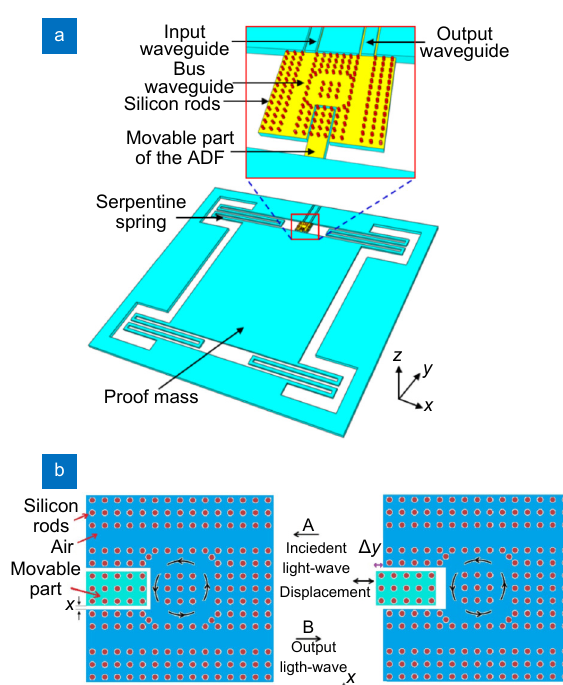
Fig. 25 | ( a ) Simplified model of a photonic crystal accelerometer along with ( b ) the working principle of ADF. Figure reproduced with permission from: (a, b) ref. 141 ,